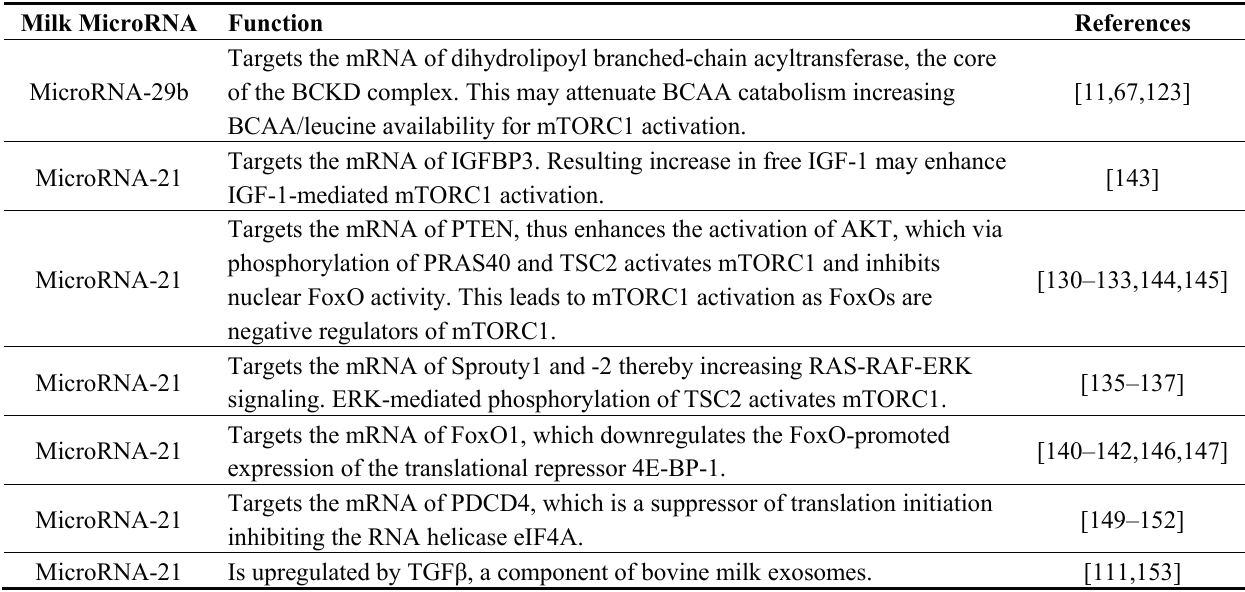
Table 3. Milk-derived exosomal microRNAs implicated in mTORC1-dependent translation. Milk MicroRNA